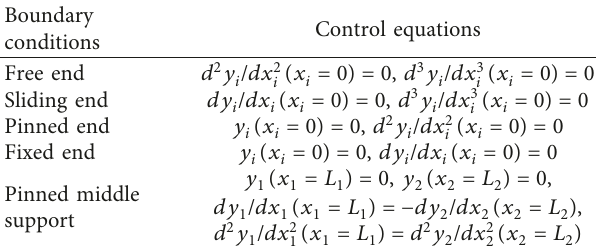
Figure 1: A typical two-span continuous timber floor. Table 1: Boundary conditions for two-span continuous